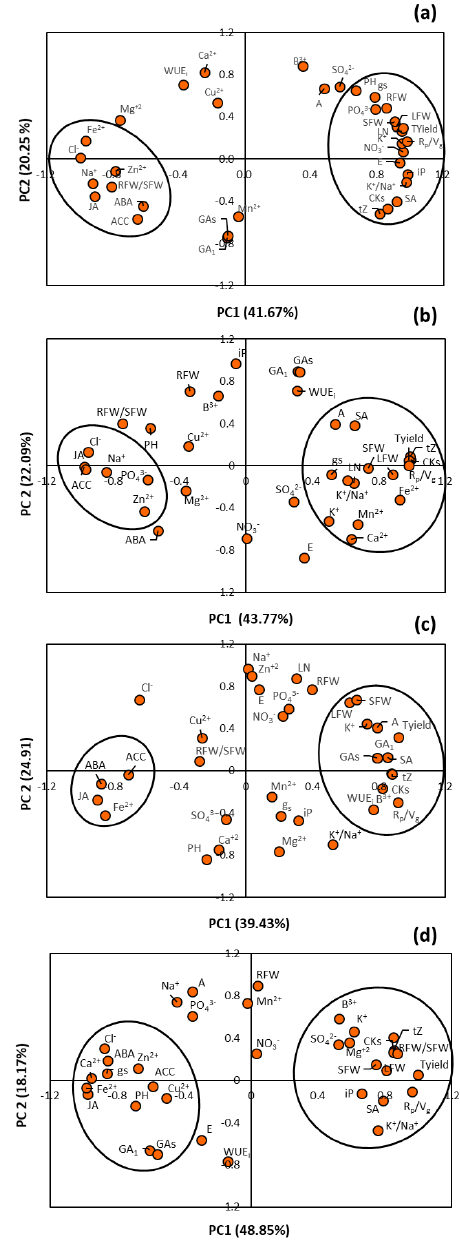
Figure 8. Two axes of a principal component (PC1, PC2) analysis showing the loadings of various growth-related, ionic, and hormonal variables (denoted by abbreviations) of pepper plants of the commercial variety “Gacela F1” either ( a ) non-grafted or grafted onto the commercial rootstocks ( b ) Creonte, ( c ) Atlante, and ( d ) Terrano, and cultivated under control (0 mM NaCl) and salinity (35 mM NaCl) conditions. SFW: Shoot fresh weight; RFW: Root fresh weight; LFW: Leaf fresh weight; PH: Plant height; LN: Leaf number; Tyield: Total yield; R p /V g : Reproductive to vegetative ratio; A: Photosynthetic rate; g s : Stomatal conductance; and E: Transpiration rate.